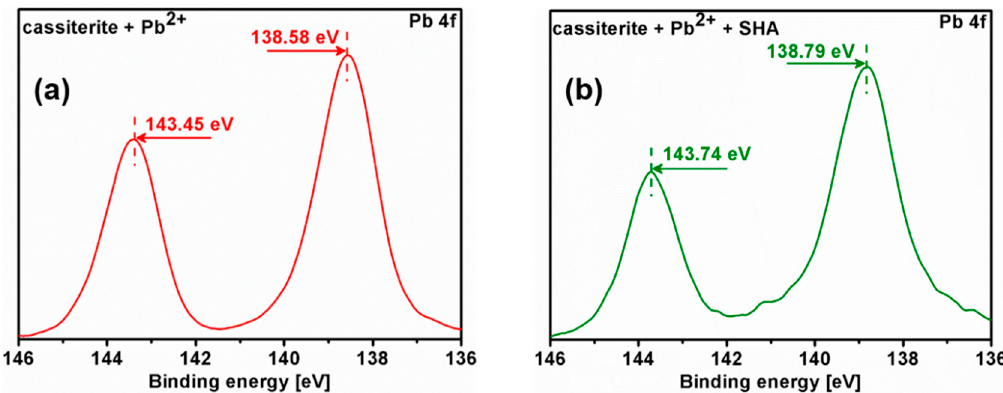
Figure 11. Pb 4f XPS spectra recorded from the surfaces of cassiterite treated by Pb 2+ in the absence ( a ) and presence ( b ) of SHA.